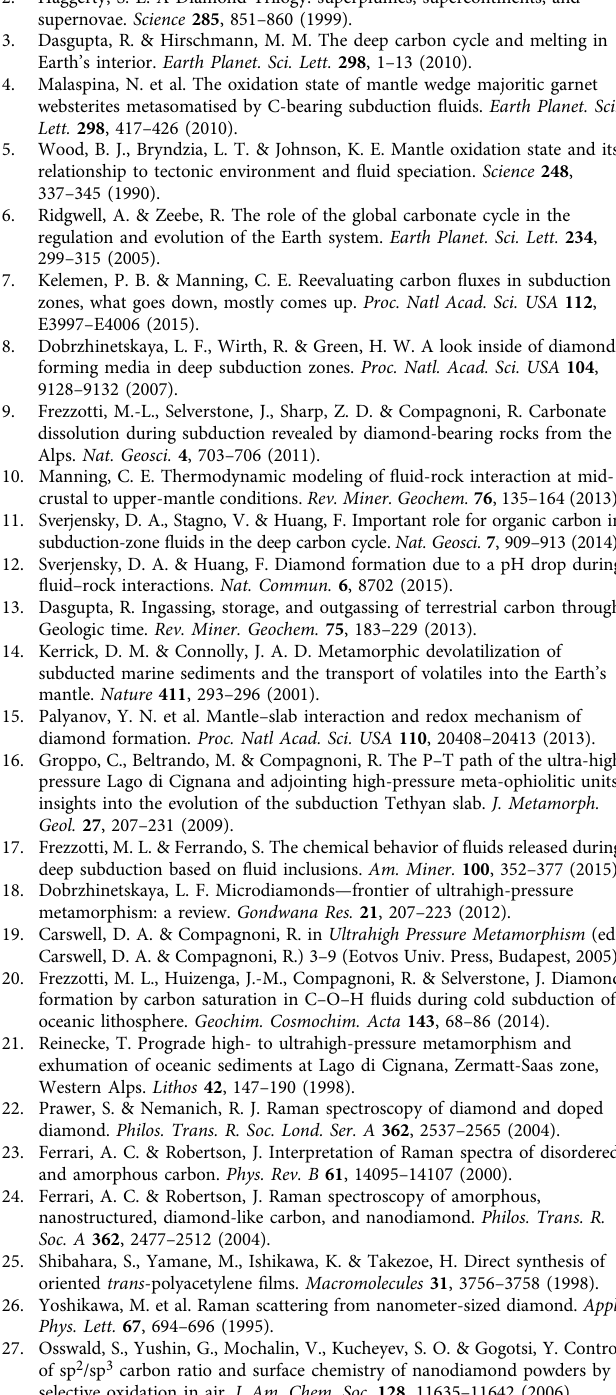
where I G is the intensity of G band within the range 1560 – 1590 cm − 1 , and I D is the intensity of the diamond peak at 1332 cm − 1 corrected for the weaker scattering at the considered laser lines 65,68 .